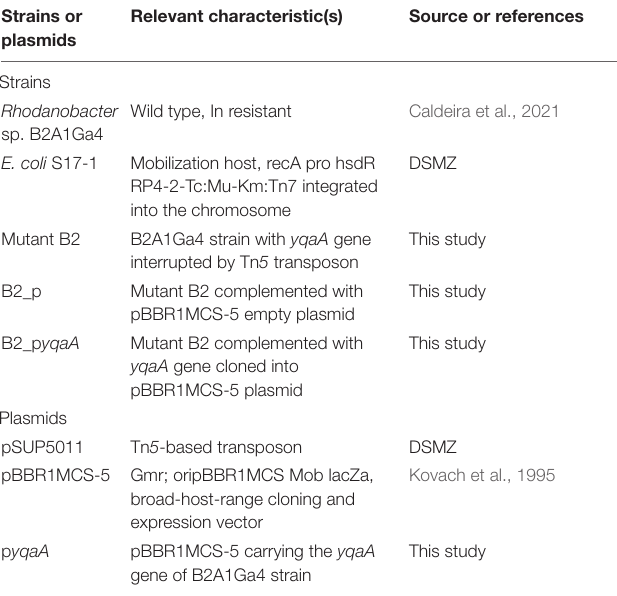
TABLE 1 | Bacterial strains and plasmids used in this